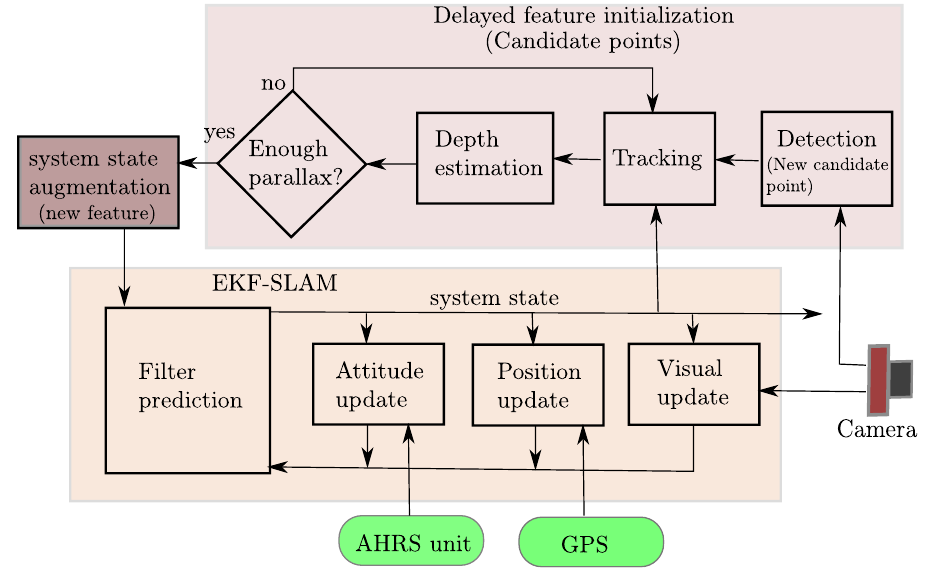
Figure 3. Block diagram showing the architecture of the system. EKF-SLAM: Extended Kalman Filter Simultaneous Localization and